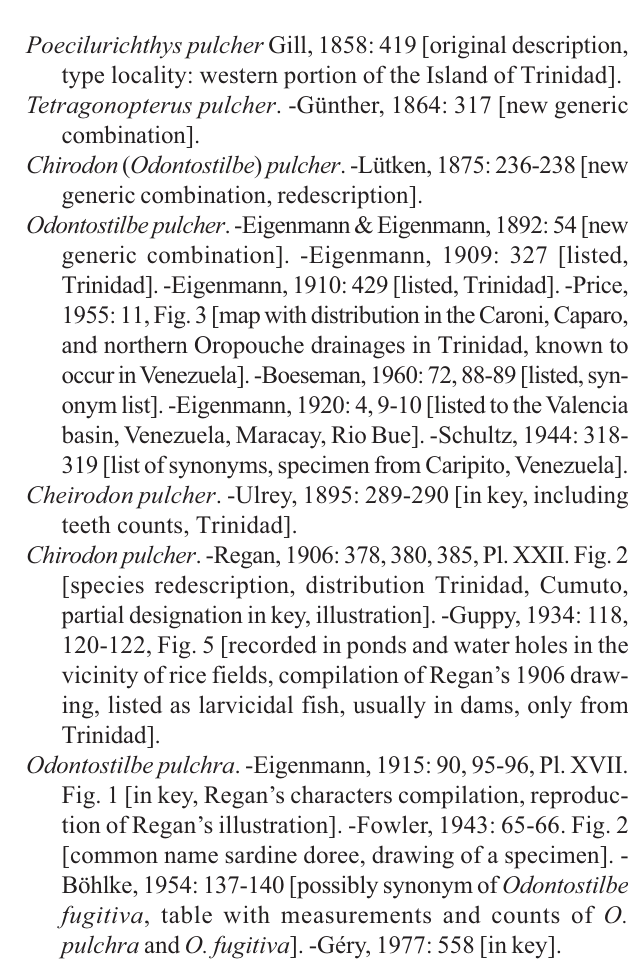
Fig. 1 [in key, Regan’s characters compilation,